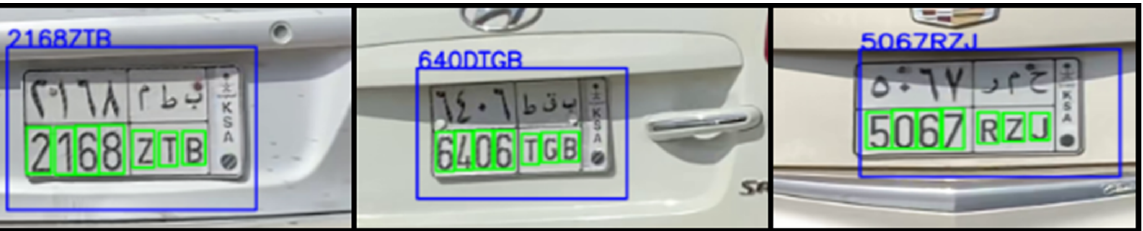
Figure 10. Recognition results of the CNN model that discards the Arabic text before performing the recognition task.